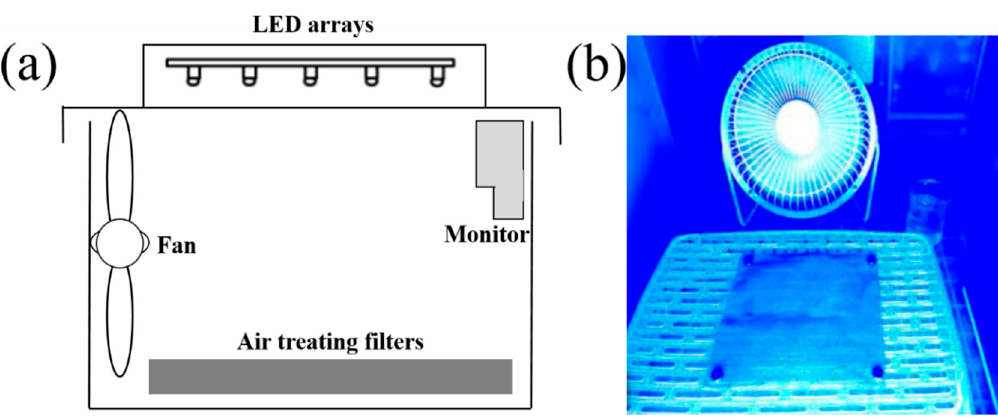
Figure 5. ( a ) The simulative air treatment devices and ( b ) a photograph of them under a working condition.